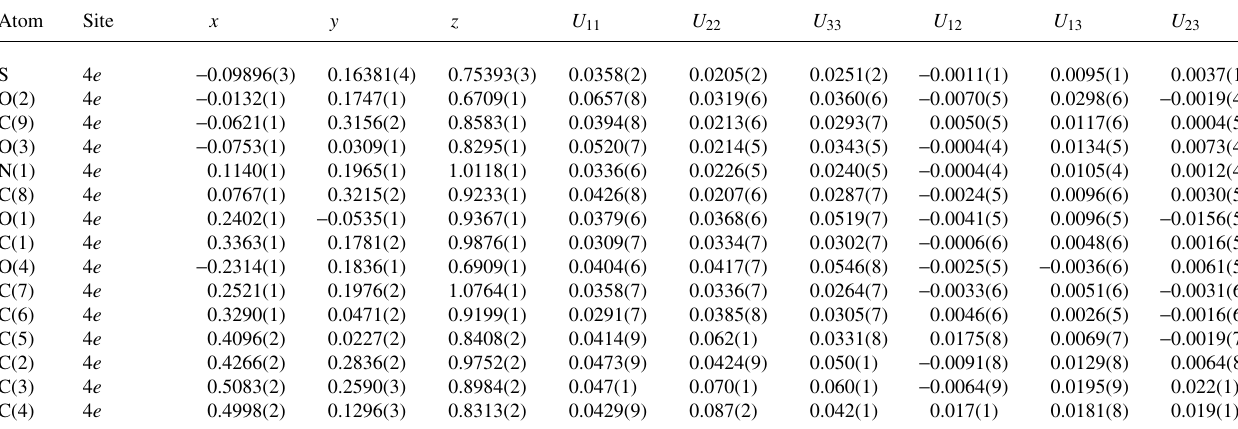
Table 3. Atomic coordinates and displacement parameters (in Å 2 )